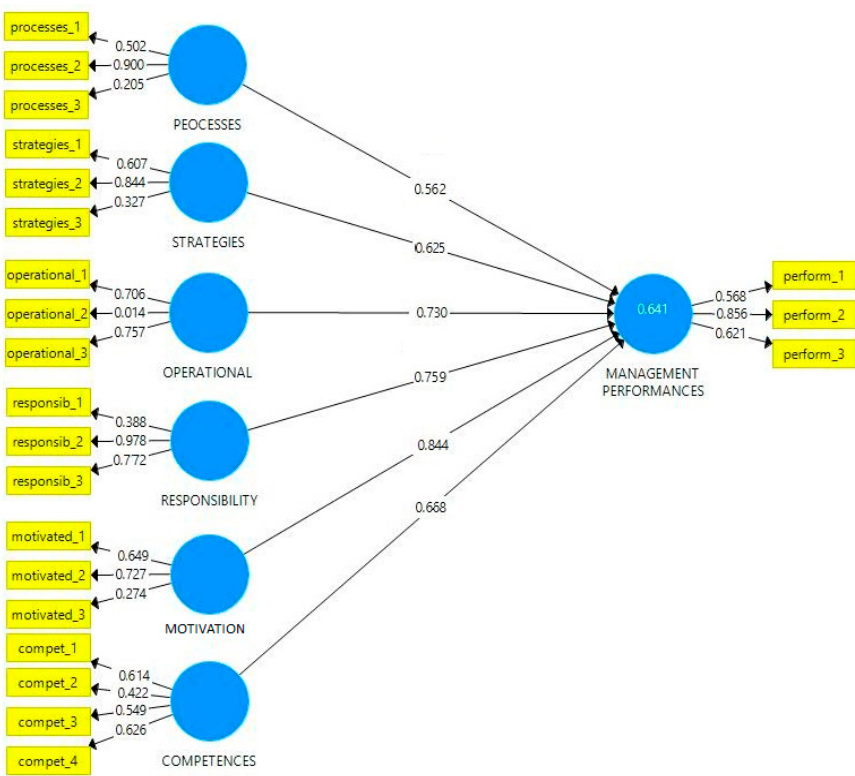
Processes 2019 , 7 , x 13 of 18 Figure 6. Partial least squares - structural equation modelling (PLS – SEM) Model 1. Figure 6. Partial least squares-structural equation modelling (PLS–SEM) Model 1.